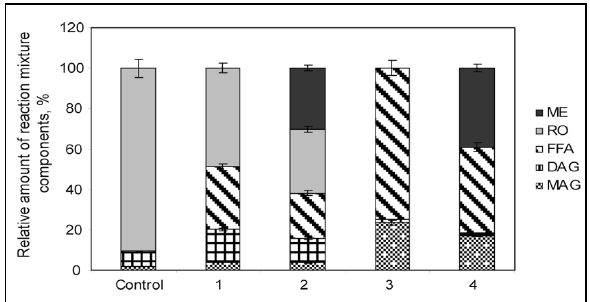
Fig. 7. Lipoprime 50T-catalyzed hydrolysis (columns 1 and 3) and methanolysis (columns 2 and 4) of rapeseed oil in n-hexane (columns 1 and 2) and in t -butanol (columns 3 and 4). Reactions were performed at 40 °C with oil-to-methanol molar ratio of 1:6, reaction time 120 h. Quantitative analysis (%) was per- formed using the Micro image 4.0 programme. Control – RO. Symbols are the same as in Fig.